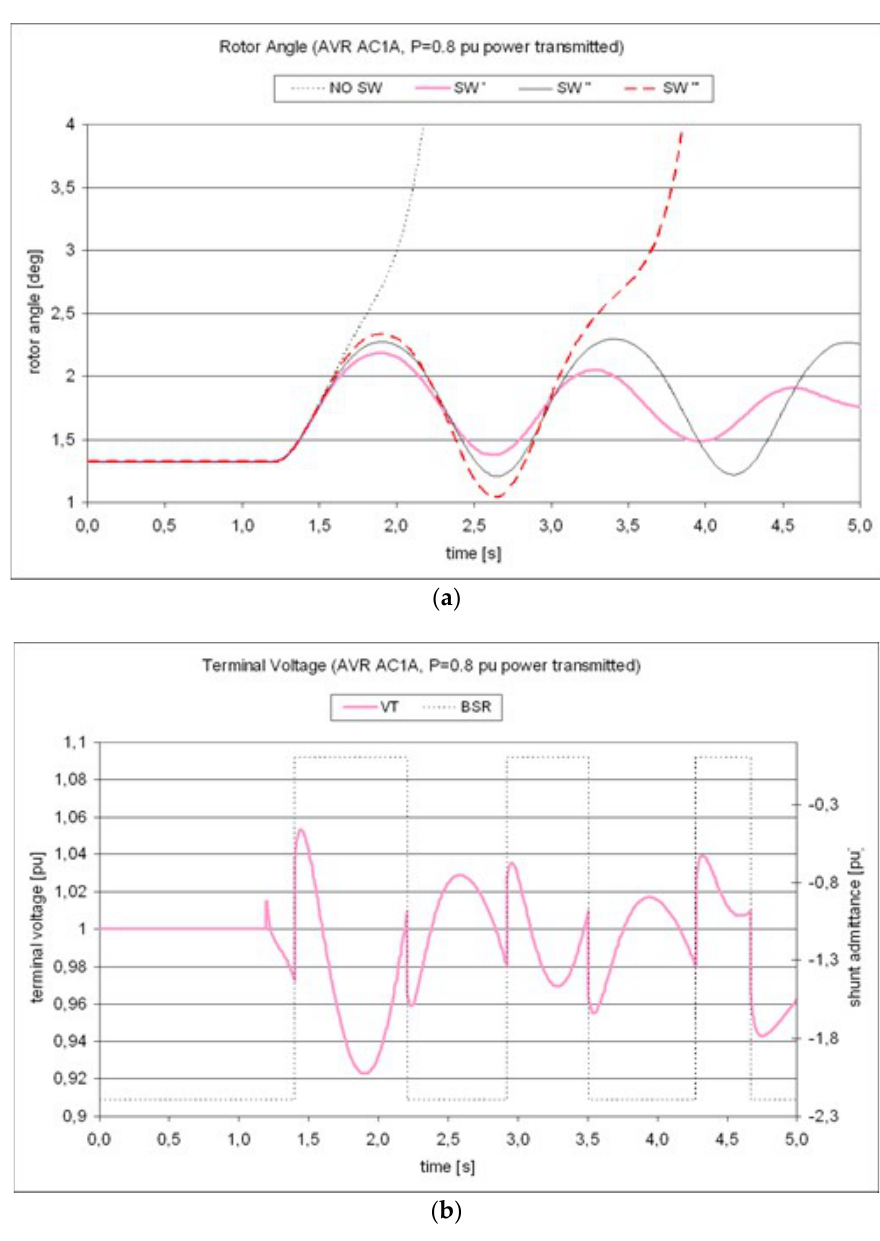
Figure 2. Simulation results of simple test system: ( a ) Rotor angle voltage for line tripping, with and without reactor switching; ( b ) Terminal voltage and shunt admittance of reactors for a line tripping in the simple system, with timely reactors switching.